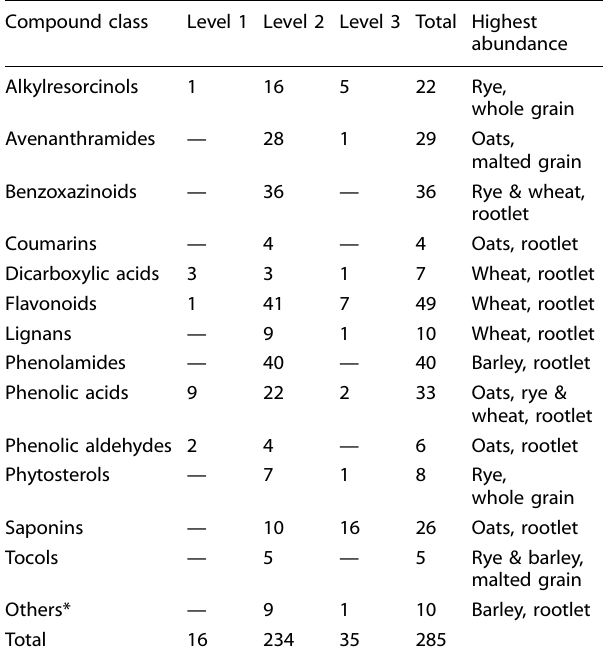
Table 1. The number of annotated compounds, categorized by compound class and level of identi fi cation according to Sumner et al. 51 : identi fi ed with reference standard (level 1), putatively annotated based on publicly available MS/MS data (level 2), and putatively characterized compound class based on physicochemical characteristics (level 3). The sample type with the highest cumulative abundance is listed for each class. *Other compound classes include alcohols ( n = 1), alkaloids ( n = 2), betaines ( n = 2), diterpenoids ( n = 2), esters ( n = 1), sphingolipids ( n = 1), and triterpenoids ( n =